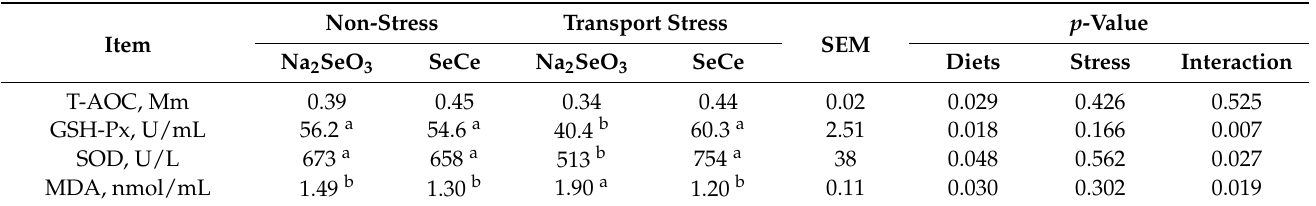
Table 4. Effects of dietary Se-enriched Cardamine enshiensis supplementation on liver anti-oxidative capacity of broilers under transport stress 1